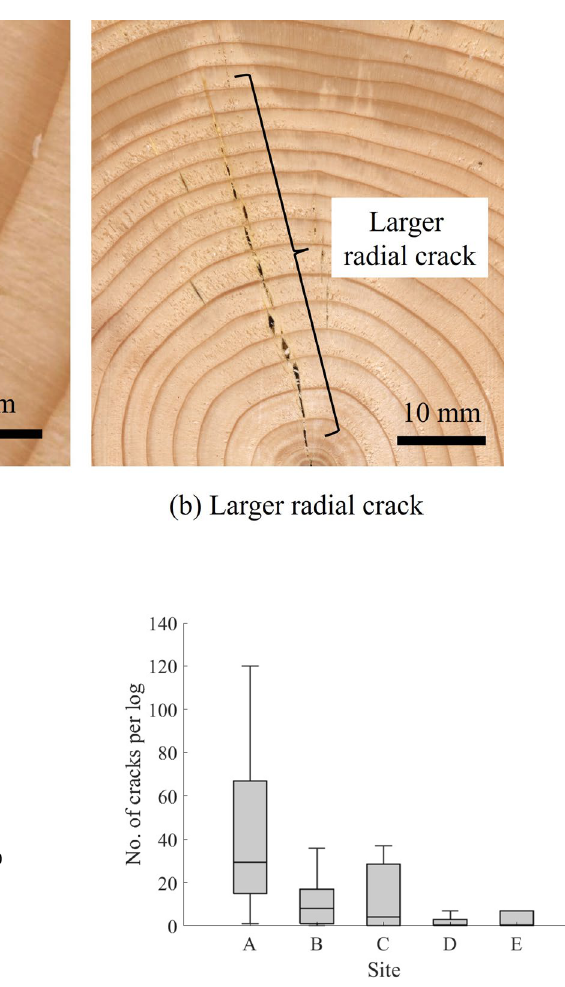
Fig. 4 Number of cracks per log at each site. (The line inside each box is the sample median. The whisker connects the upper quartile to the non-outlier maximum.)